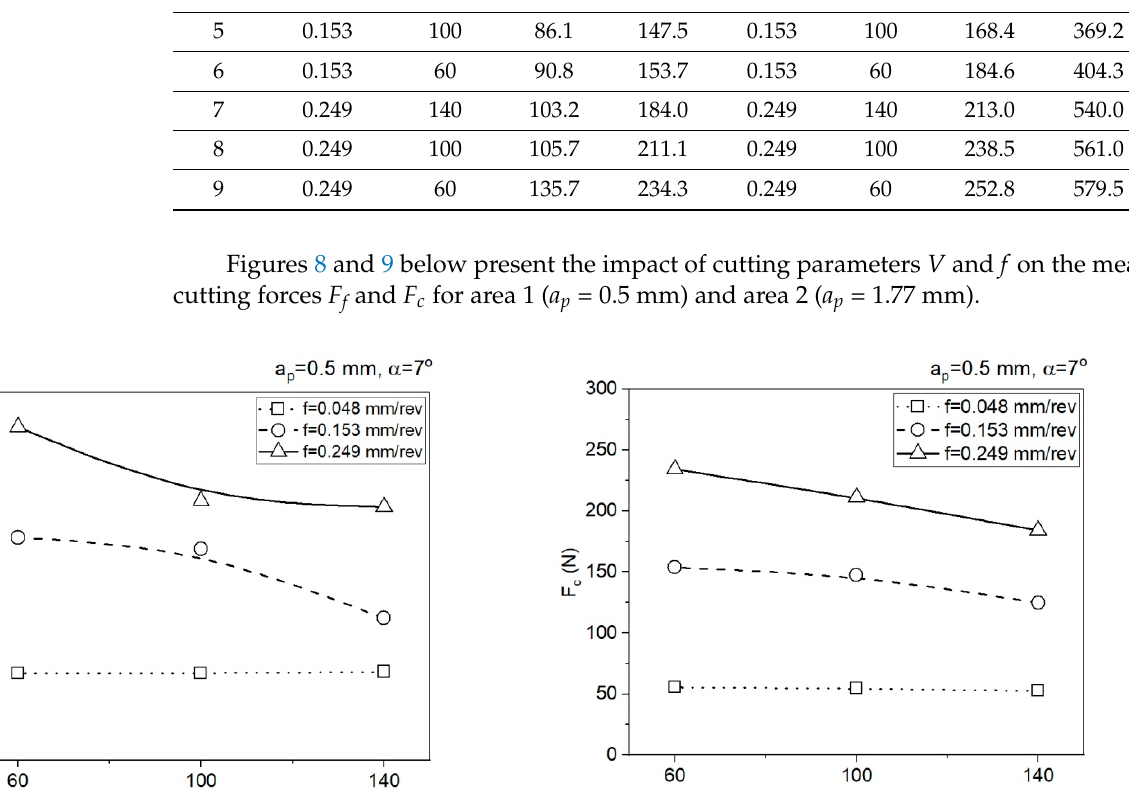
Table 7. Mean values of cutting forces recorded during the orthogonal turning of GRADE 2 titanium alloy.